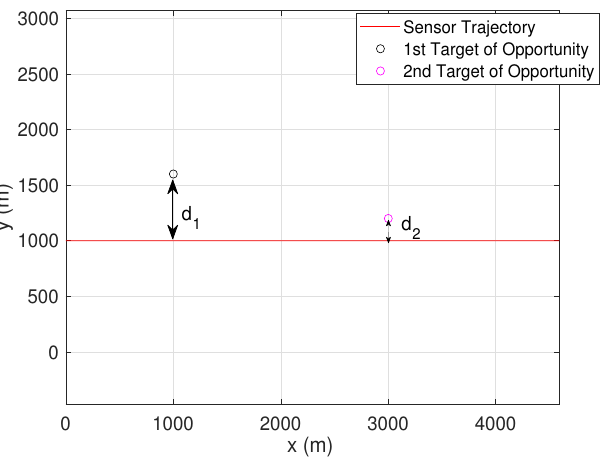
Figure 3. Sensor trajectory following CV model for bias estimation using two targets with known locations and terrain